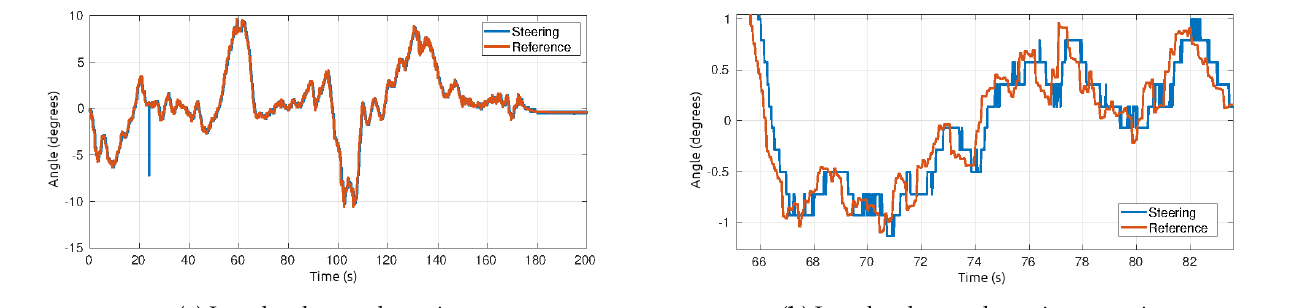
Figure 20. Lateral low-level control